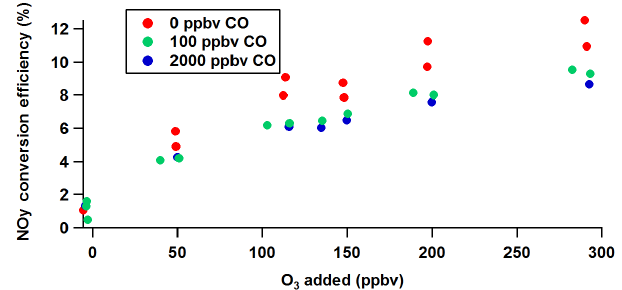
Figure 9. Conversion efficiency of NH 3 to NO 2 as a function of O 3 added to the TD inlet. Red circles show 10ppbv NH 3 with O 3 ranging from 0 to 300ppbv, and the green and blue traces show similar data, but with 100 and 2000ppbv CO added. The partial depletion of the signal ( ∼ 25%) with the addition of CO indicates that the oxygen atoms formed from O 3 pyrolysis are reacting with CO instead of NH 3